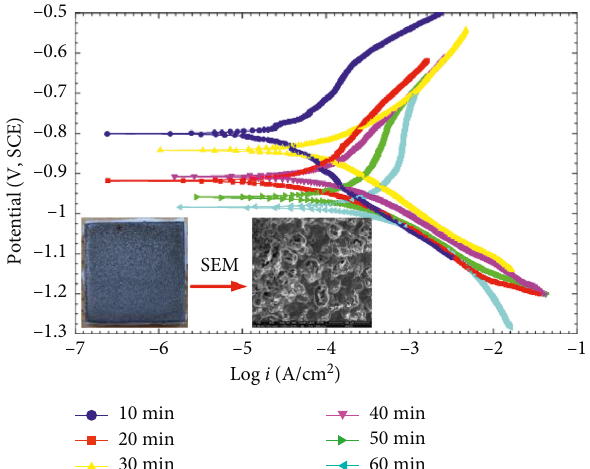
corr . Figure 3: Experimental results of stray current corrosion on